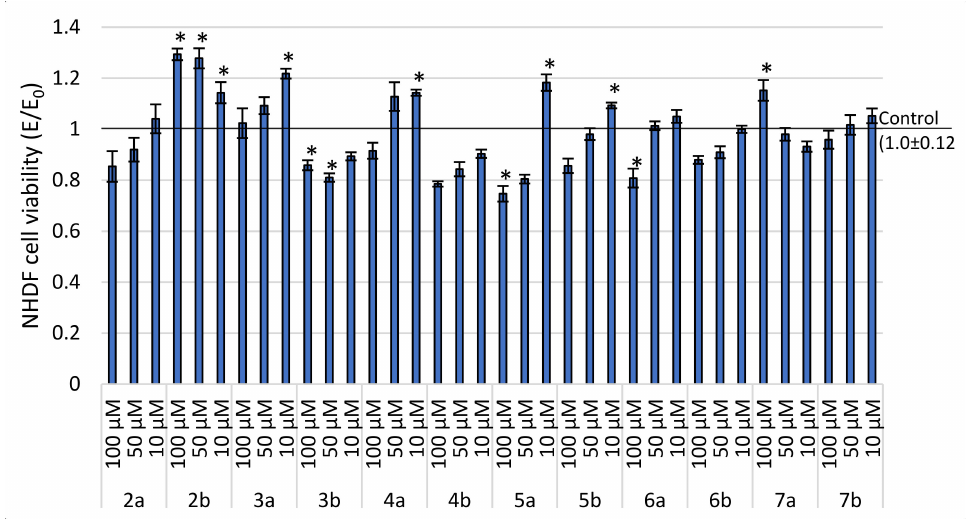
Figure 2. Impact of investigated compounds on normal human dermal fibroblasts measured in MTT assay; * p < 0.05—significant difference compared to control without tested compounds.